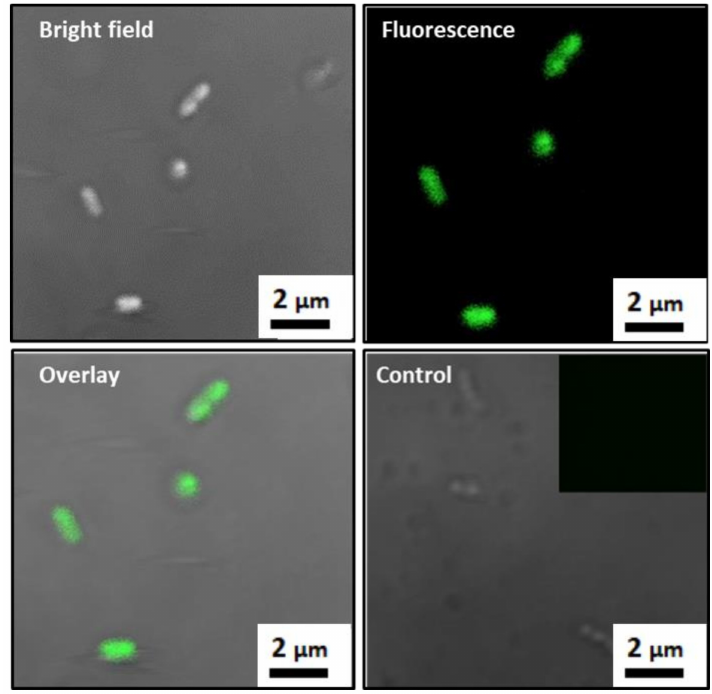
Figure 2. Confocal microscopy images of FITC-labeled MTB/PEG-biotin complexes. Photomicro- graphs show the bright field, fluorescence, and overlay confocal microscope images. Unlabeled bacte- ria are used as controls. Inset shows unlabeled bacteria (controls) that do not exhibit any